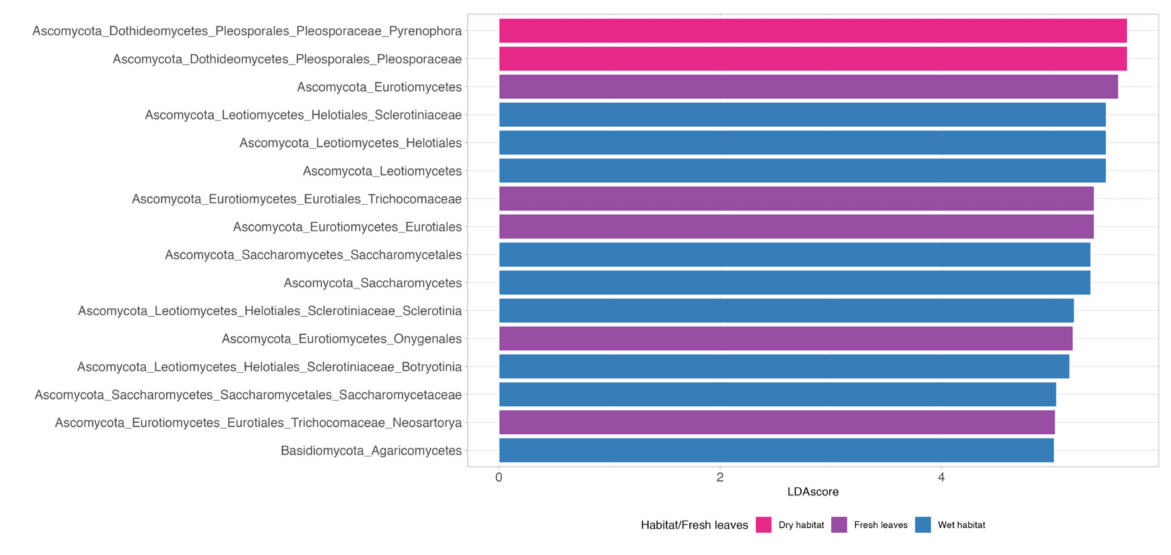
Figure 3. Identification of indicator taxa based on Lefse analysis (LDA scores > 5).